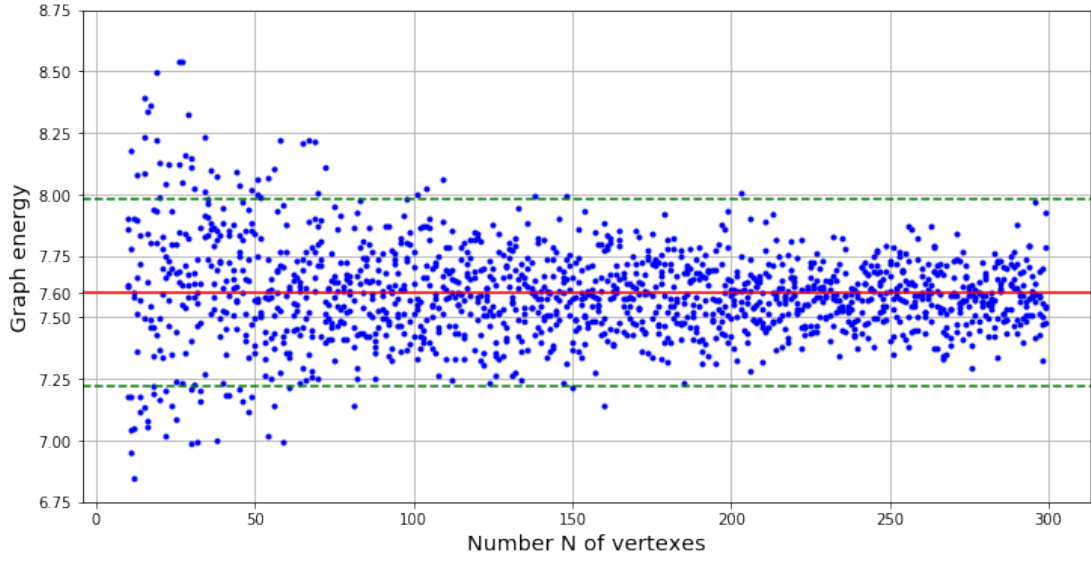
Figure 11. Dependence of graph energy on the number of vertexes N